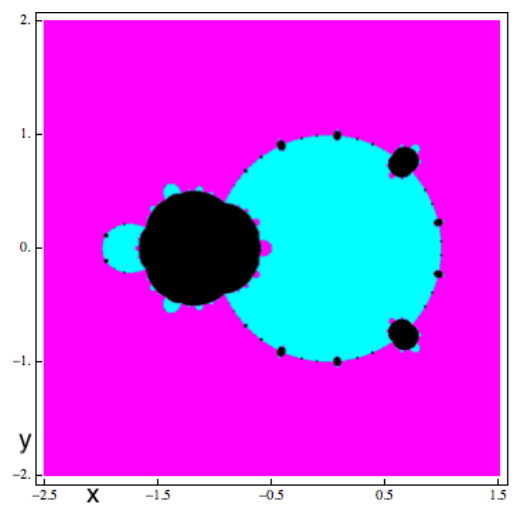
Figure 5. Basins of attraction associated with the member r = 1 and t = − 5.